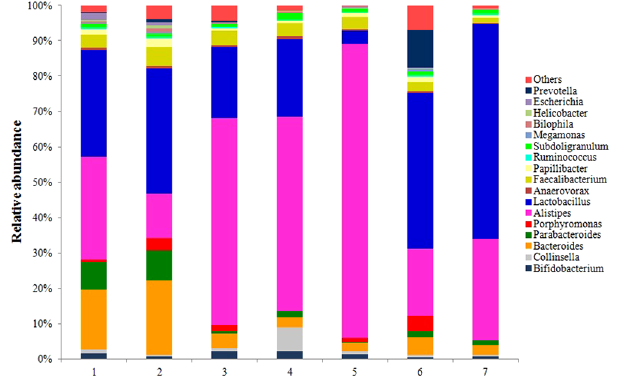
Figure 3. Genus-level composition of the caecal microbiome of chicken. A color-coded bar plot shows the average bacterial genus distribution in different treatment groups and control group. The number of 1, 2, 3, 4, 5 and 6 refer to the probiotic-treated group (Group 1 to Group 6), the number 7 refer to the control group (Group 7).